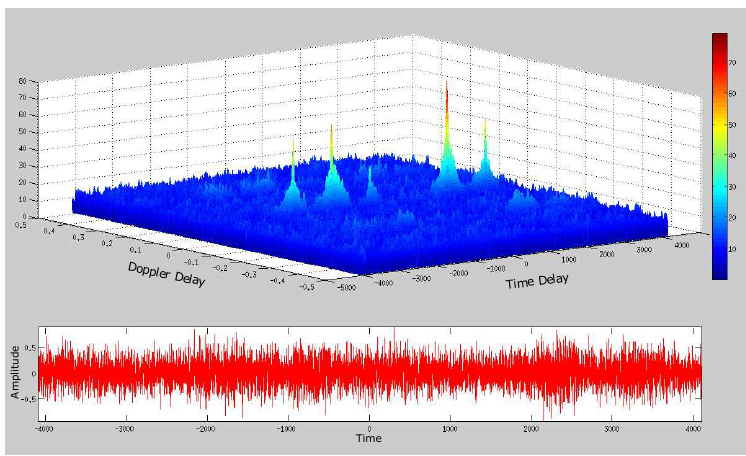
Figure 34. Multiple object tracking using MMPP “chirp pulses”, at Tracking Time 5, with − 5 dB